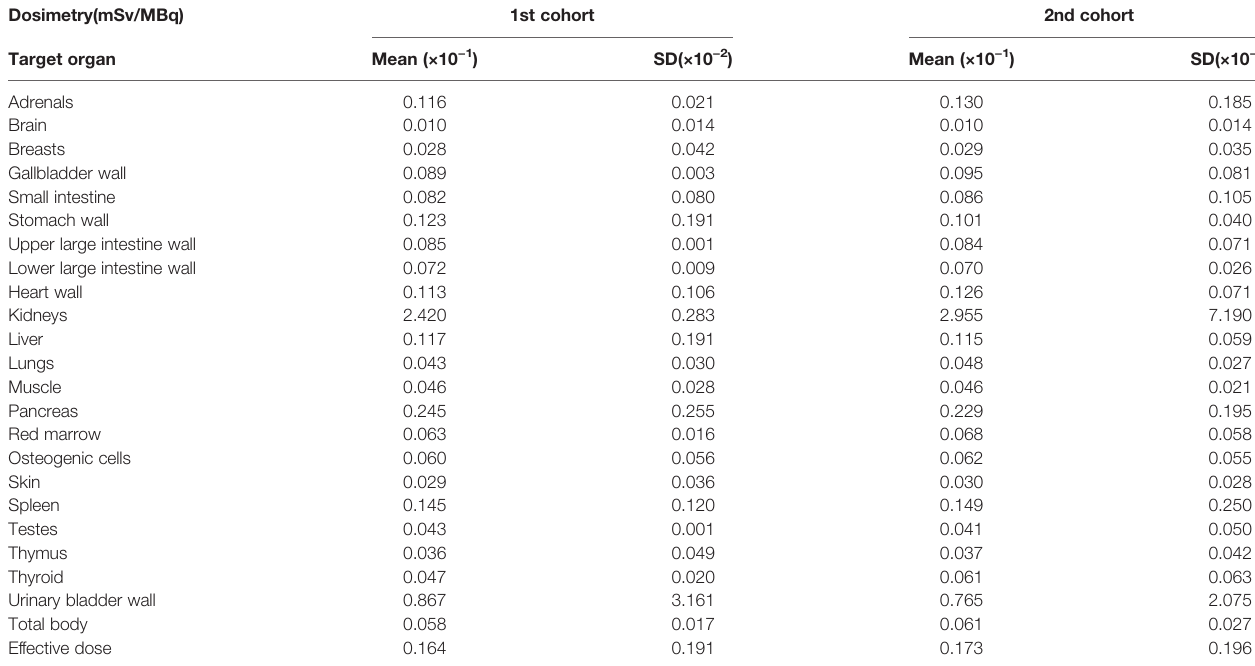
TABLE 3 | The results of dosimetry of [ 18 F]FB(ePEG12)12-exendin-4 ( 18 F-Ex4) in the fi rst and second